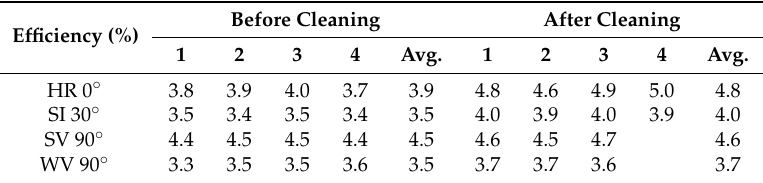
Figure 10. PV array efficiency before and after cleaning. Table 6. PV array efficiency before and after